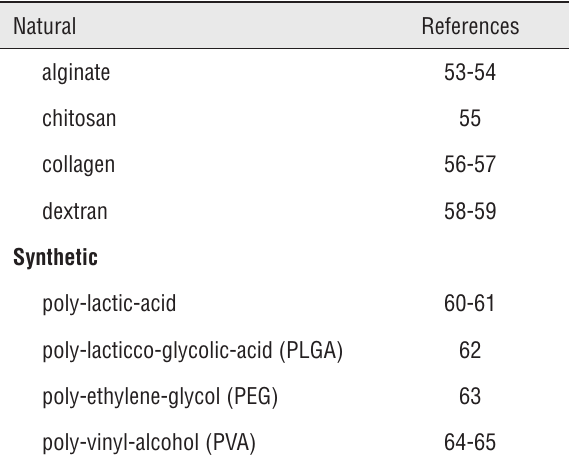
Table 3 - Options for Synthetic Device